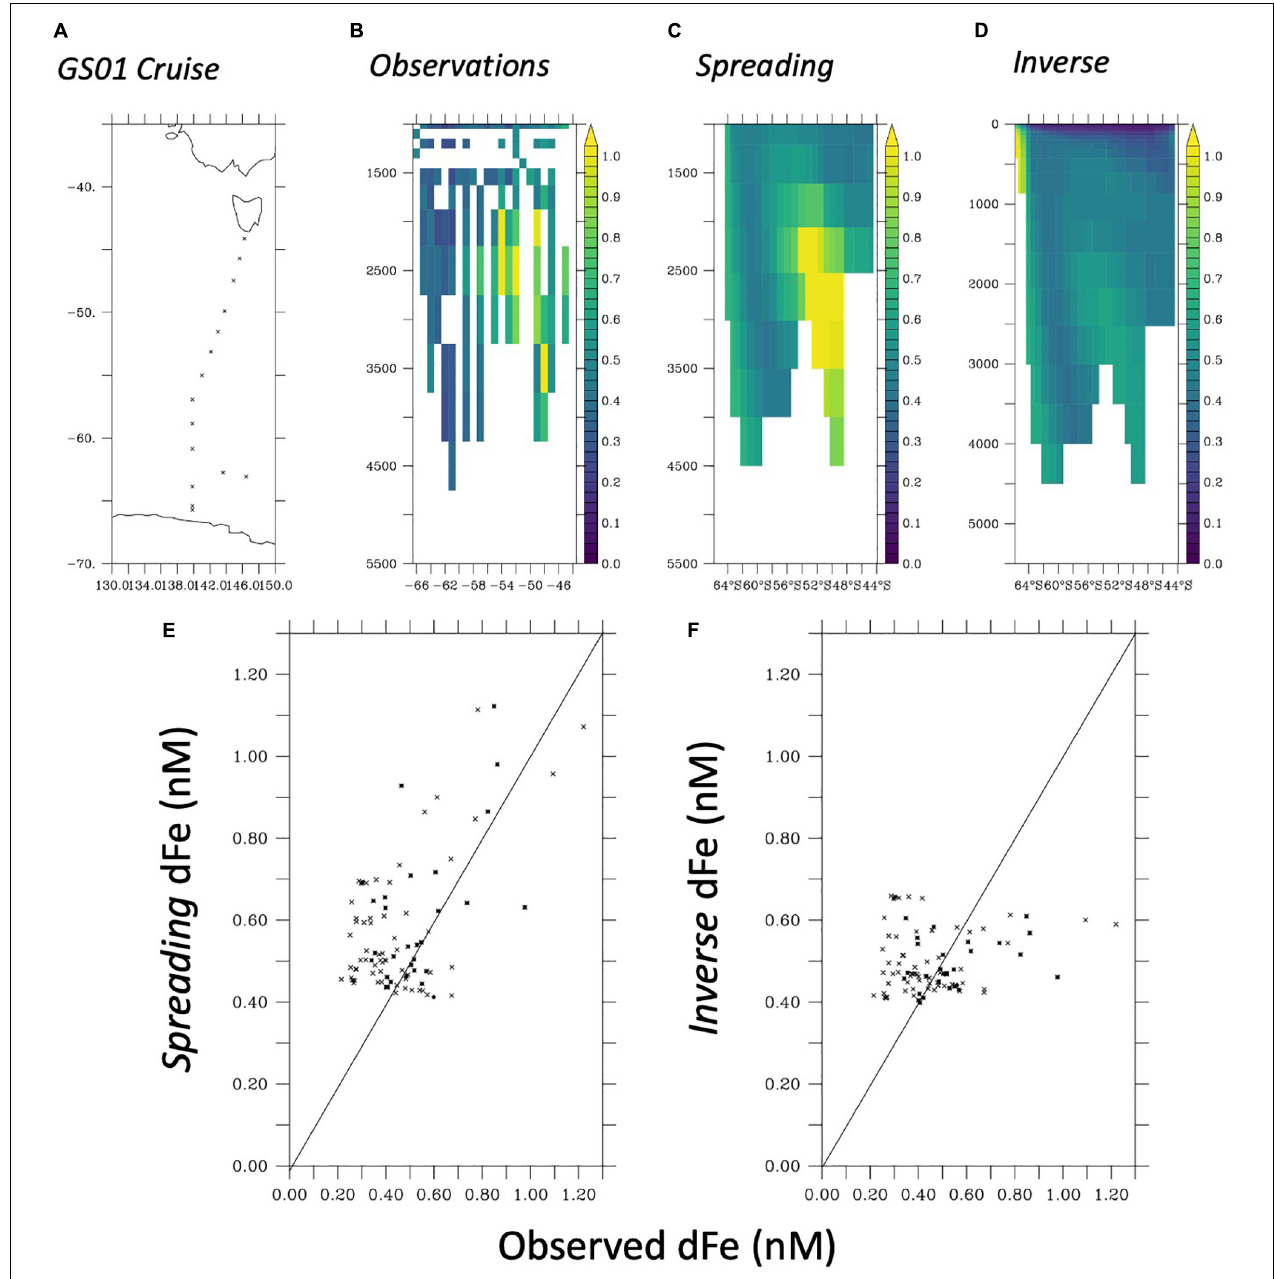
FIGURE 4 | (A) Cruise track from GS01 section, (B) dFe observations from GS01 binned onto the model vertical axis deeper than 1,000 m, (C) modelled dFe from the spreading experiment, (D) modelled dFe from the inverse experiment. (E,F) Present a cross plot of modelled and binned observed dFe from the spreading and inverse experiments for the same model grid cells deeper than 1,000 m [the 1:1 line is marked in black for (E,F)